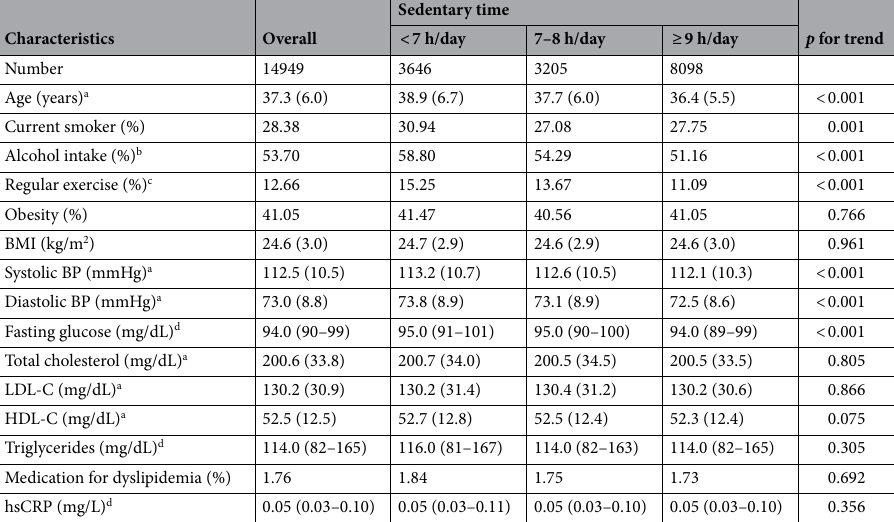
Table 1. Baseline characteristics of study participants by reported sedentary time. BMI body mass index, BP blood pressure, LDL-C low-density lipoprotein cholesterol, HDL-C high-density lipoprotein cholesterol, hsCRP high-sensitivity C-reactive protein. a Data are presented as the means (standard deviation). b Data are presented as percentage (the proportion of participants who intake more than 10 g of alcohol a day). c Data are presented as percentage (the proportion of participants who answered that they had vigorous physical activity for more than 3 days per week). d Data are presented as the median (interquartile range), or percentage.